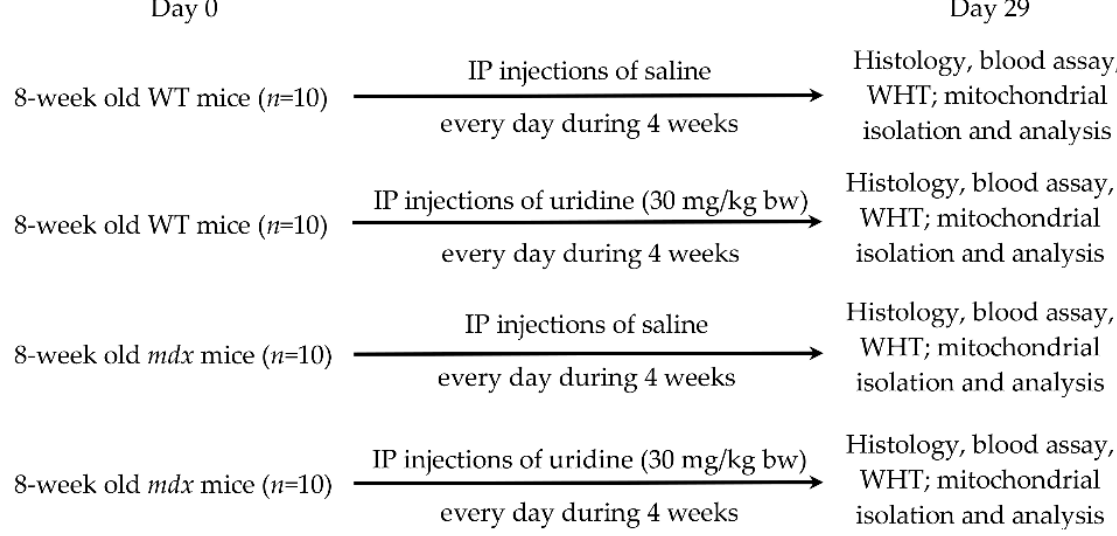
Figure 1. The experimental protocol of the study. IP: intraperitoneal; WHT: wire hanging test.